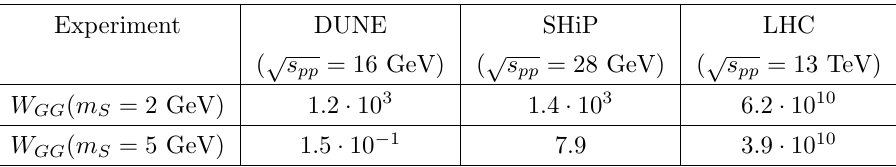
Table 1 . Factors W GG (see eq. (2.2)) for the DUNE, SHiP and LHC